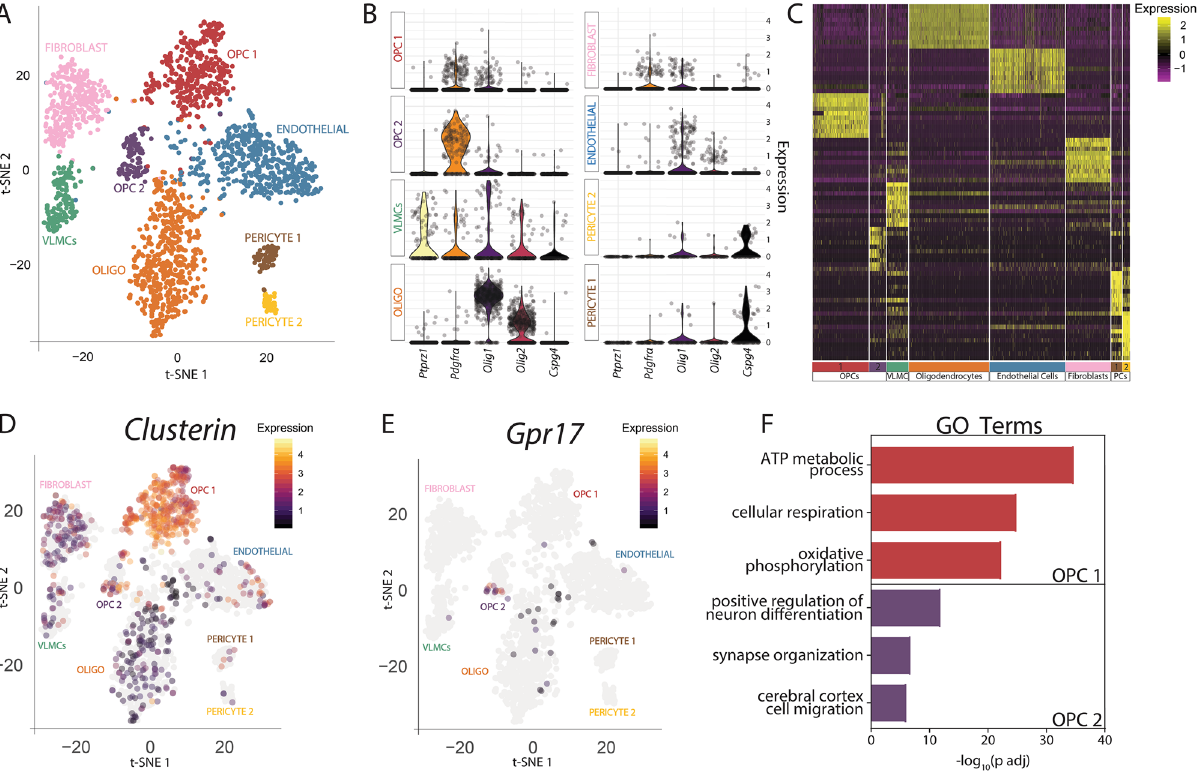
Figure 3. Adult OPCs cluster in two distinct subpopulations. ( A ) tSNE plot of all sequenced cells isolated from PDGFRα-Cre ER reporter brains. Clusters were labeled with cell-type classifications based on expression of common cell-type markers. N = 3 independent experiments, n = 6 biological samples (3 males and 3 females). ( B ) Violin plots depicting expression of common OPC markers in each cluster. Each dot represents a cell. Expression value is plotted on the y-axis. ( C ) Heatmap depicting the scaled and log-normalized expression values of the top 10 most highly enriched genes in each cluster. ( D ) Cell-specific expression of Clusterin used for cluster validation of OPC1 overlaid on the tSNE map. ( E ) Cell-specific expression of Gpr17 used for cluster validation of OPC2 overlaid on the tSNE map. ( F ) Significant GO terms uniquely upregulated in one OPC cluster compared to each OPC cluster and VLMCs. PCs